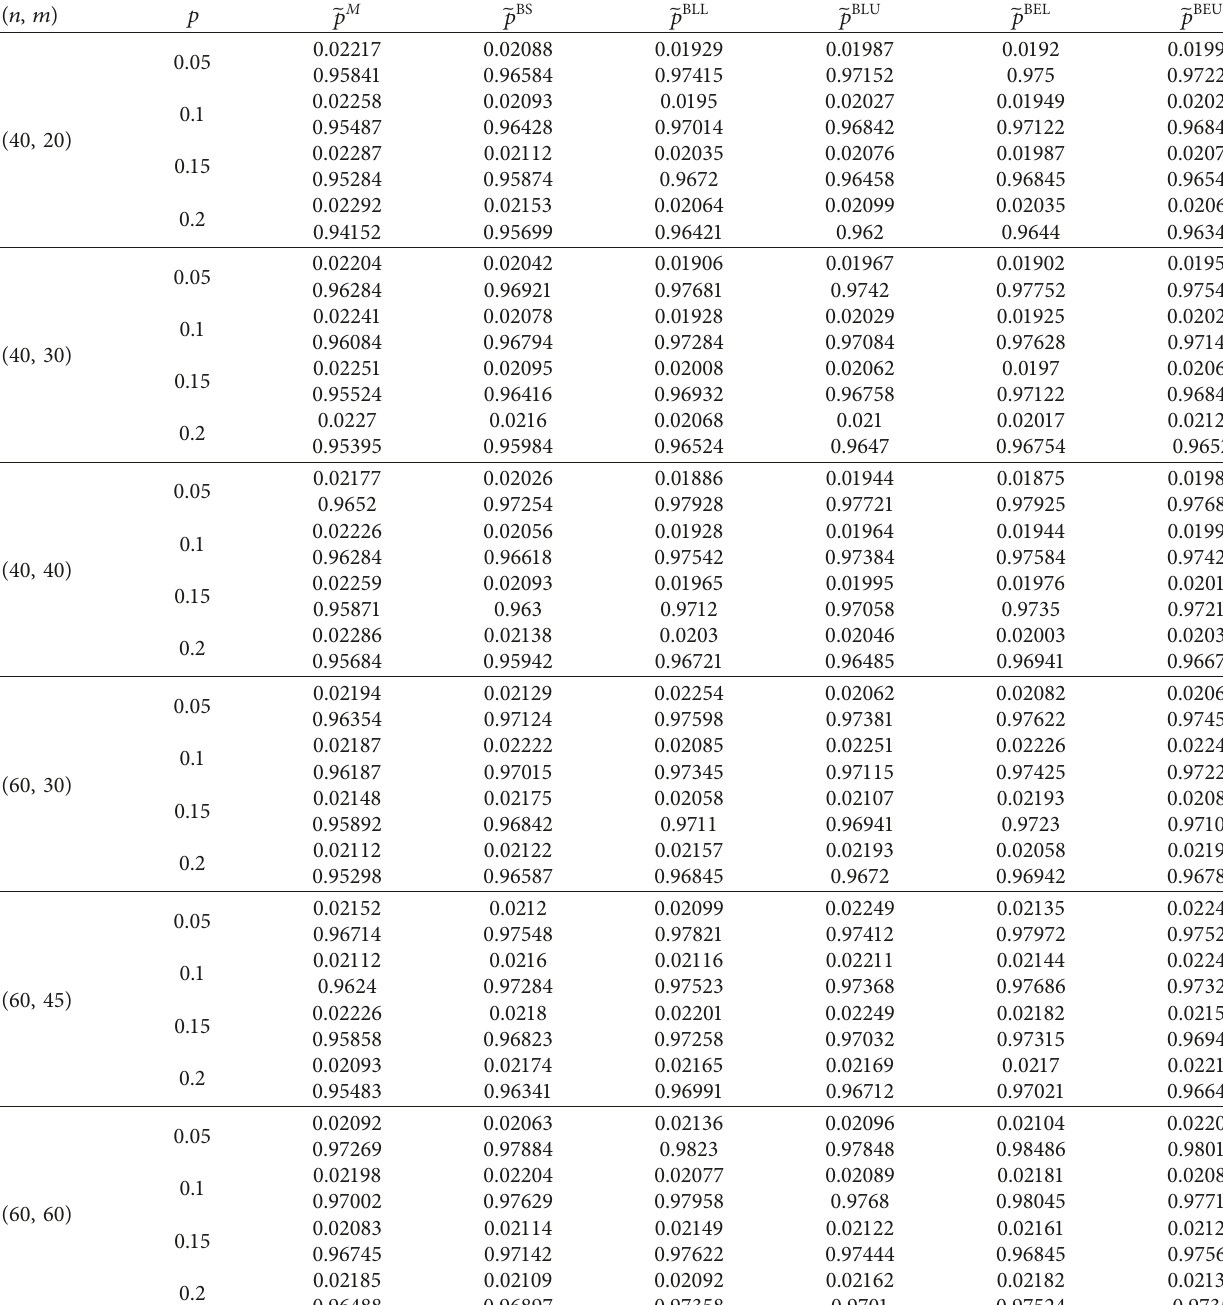
Table 13: Confidence interval of p with their coverage probability for different m for n and p